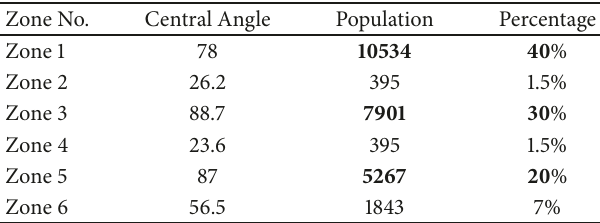
Table 3: Distribution of population in different